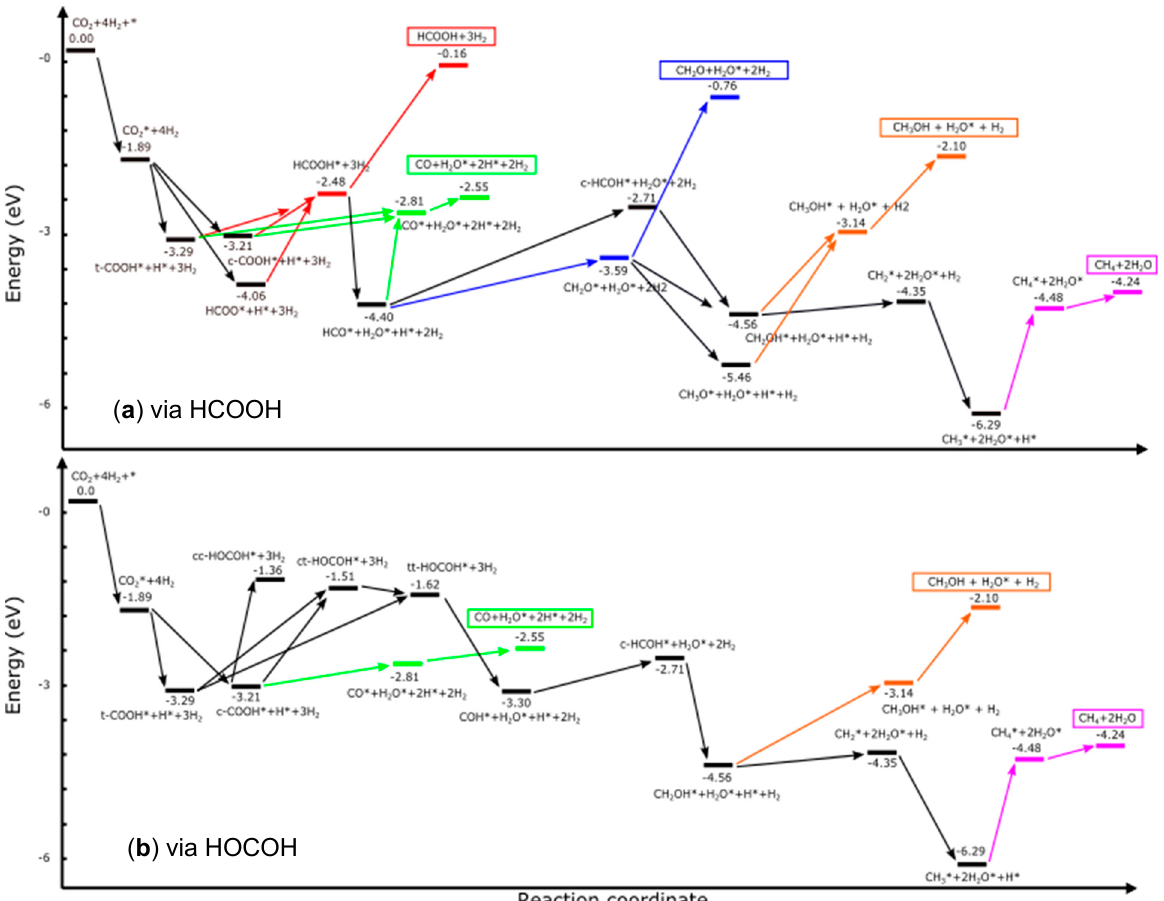
Figure 3. Reaction profile for the hydrogenation of CO 2 and subsequent reactions of intermediates to HCOOH, CO, CH 2 O, CH 3 OH, and CH 4 via ( a ) HCOOH and ( b ) HOCOH at the TaC (111) surface.